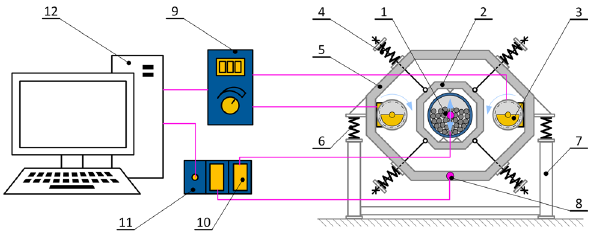
Figure 1: Schematic presentation of the research set - up.